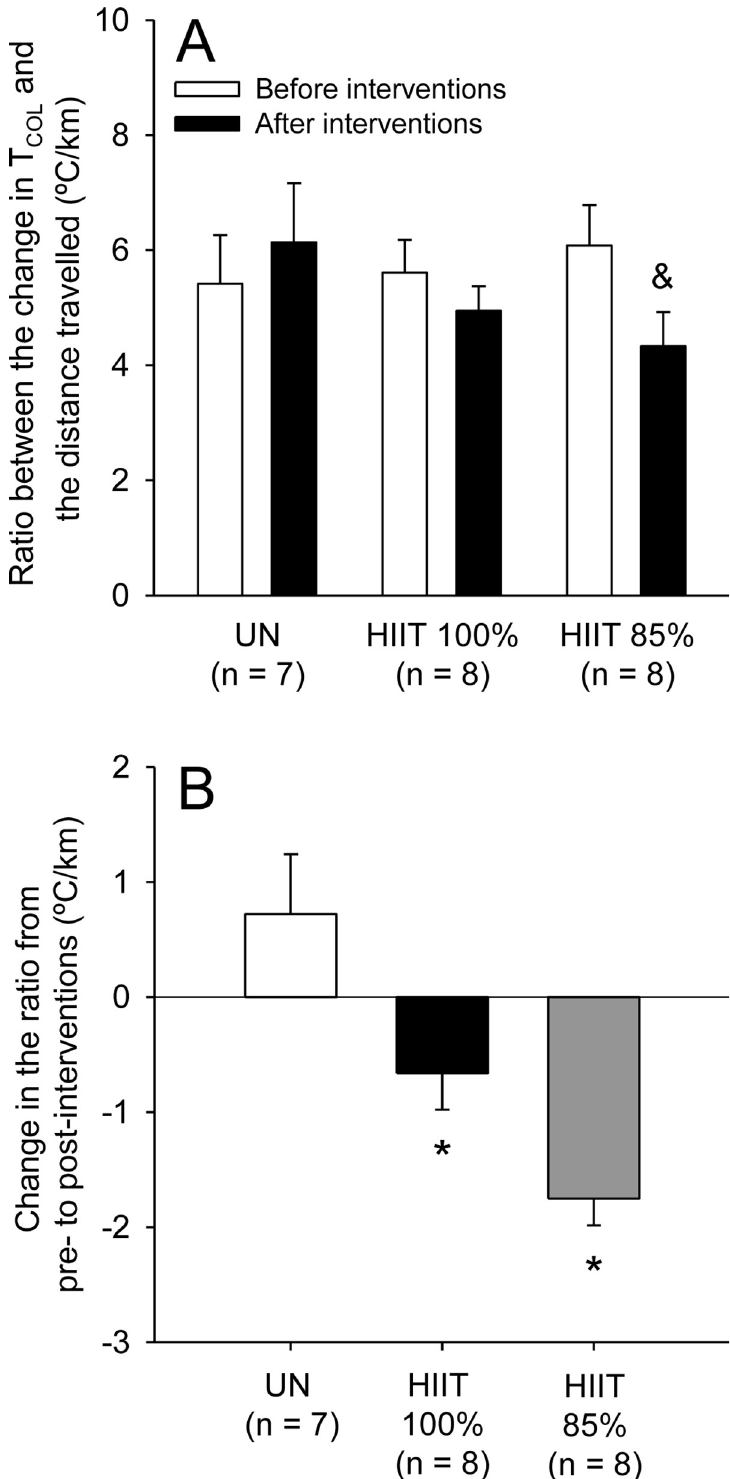
Fig 8. Ratio between the change in colonic temperature (T COL ) and the distance travelled in rats of the three experimental groups during the incremental exercises at pre- and post-interventions (panel A). Change in the ratio from pre- to post-interventions (panel B). The values are expressed as the means ± SEM. HIIT 100% : high-intensity interval training at 100% of maximal speed; HIIT 85% : high-intensity interval training at 85% of maximal speed; UN: